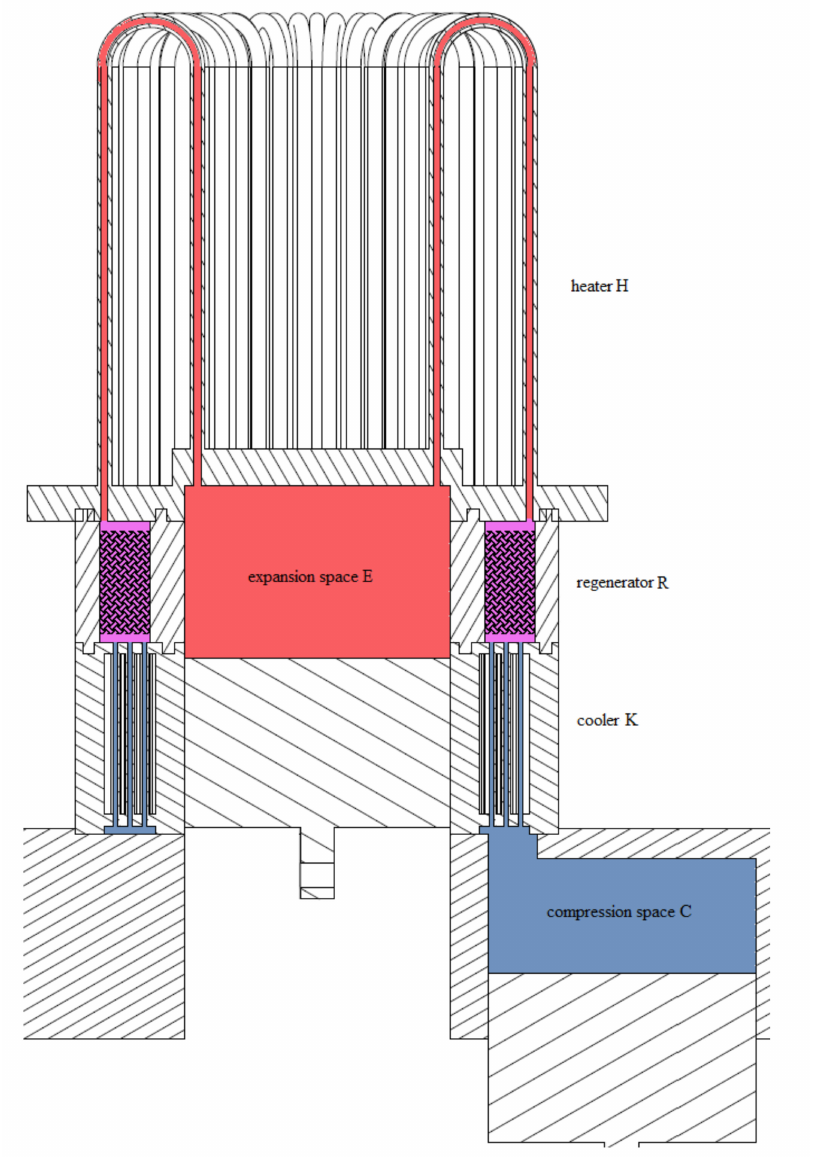
Figure 2. View of the middle section of the engine component